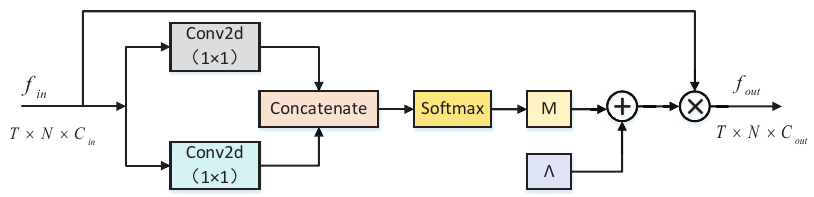
Figure 1. Adaptive graph